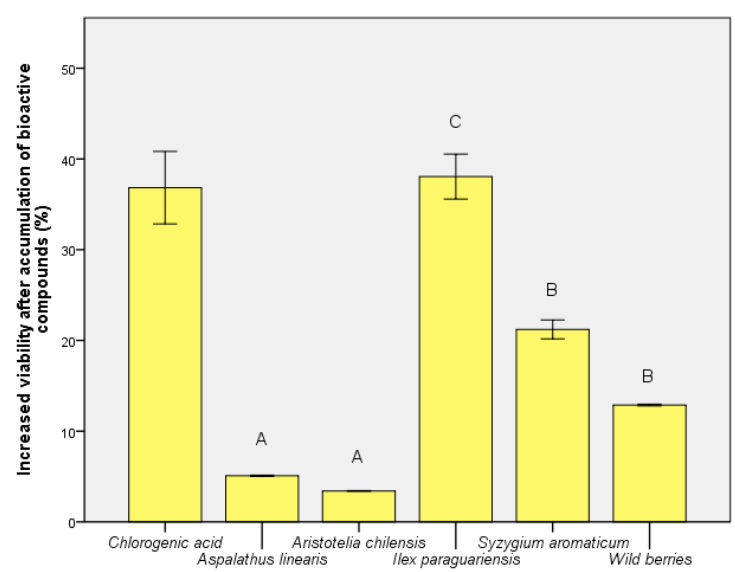
Figure 6. Increased viability of S. boulardii cells after bioactive compound assimilation. Different letters represent significant statistical differences (chlorogenic acid vs. samples; p ≤ 0.05), n = 3; chlorogenic acid was used as control.